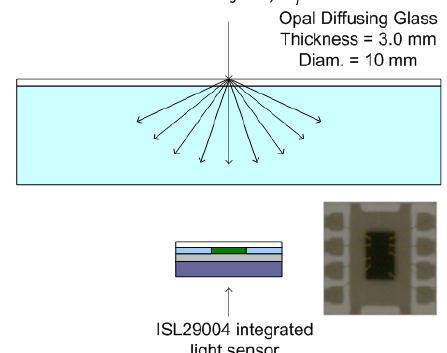
Figure 2. Left, the cosine collector of the ASD FieldSpec pro was placed on a tripod about 1.5 meters from the ground. Right, the FPI spectral camera mounted under a helicopter UAV and the irradiance sensor mounted to the tail boom. The irradiance sensor installed in the UAV is based on the Intersil ISL29004 photodetector (Intersil, 2011). The structure of the down dwelling irradiance sensor is described in figure 3. The photodetector dimensions are 3 mm x 3 mm x 1.0 mm. The signal dynamic range is 16 bits. The spectral sensitivity range is 400 – 1000 nm (D2 output used, see Figure 4). The acceptance angle of the sensor has been increased by placing an opal glass diffuser in front of the sensor (distance  3 mm). The sensor was not calibrated to measure in W/m 2 and only relative, broadband irradiance intensity values were obtained, providing single correction factor for all layers, C j .